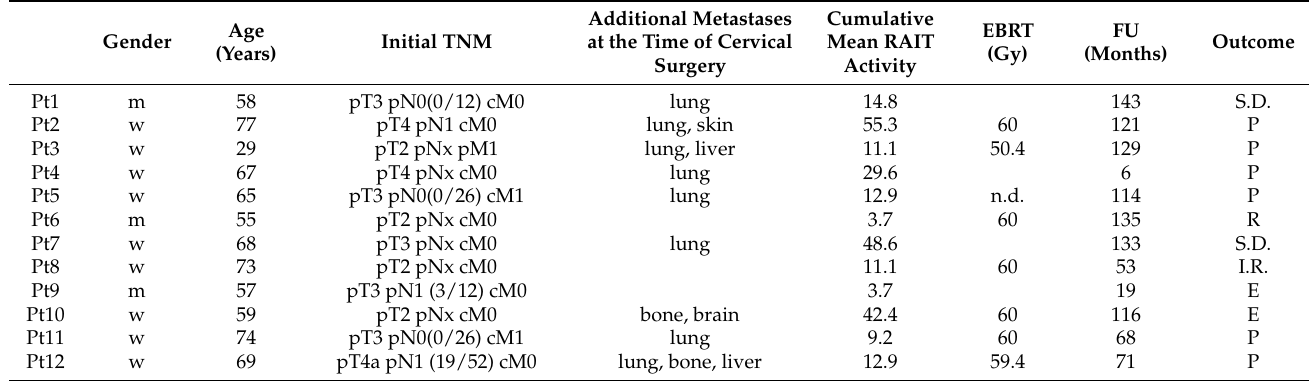
Table 1. Characteristics, treatment, and outcome of patients undergoing repeated cervical surgery for loco regional radioiodine refractory recurrence.